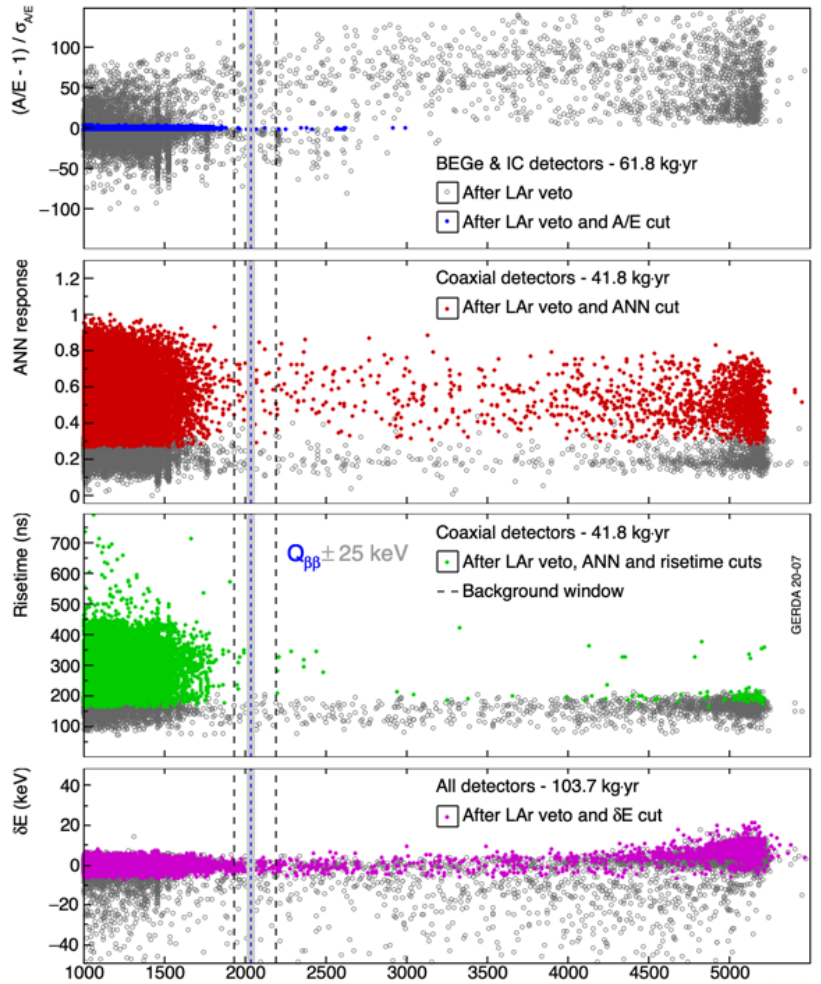
Figure 23. The event distributions for the C OAX and the BEG E &IC physical data sets, following the LAr veto cut (grey) and after applying the PSD classifier cut (colored) as a function of the energy: PSD for C OAX is done by the ANN, the risetime and the δ E selection applied one after the other. For BEG E , the PSD is performed by selecting events by the A/E and the δ E, as explained in the text. The effect of the LAr cut is shown in Figure